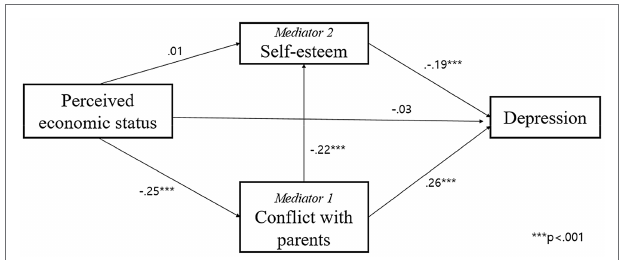
FIGURE 2 | Multiple mediating effect of conflict with parents and self- esteem.